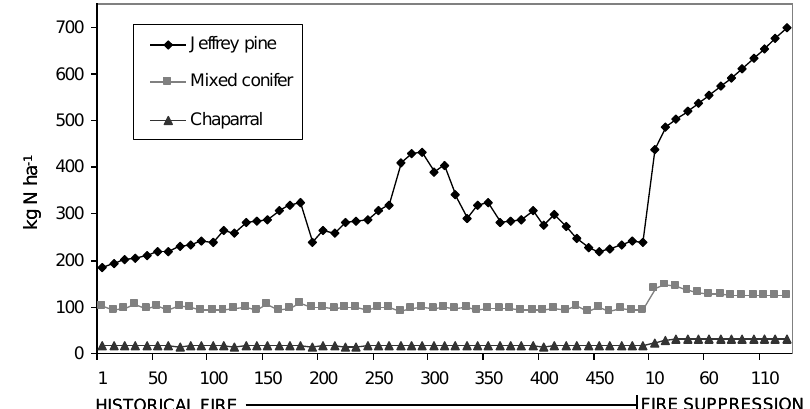
Figure 2. Average modeled litter N contents for each PNV type for 500 years of historical fire and 130 years of fire